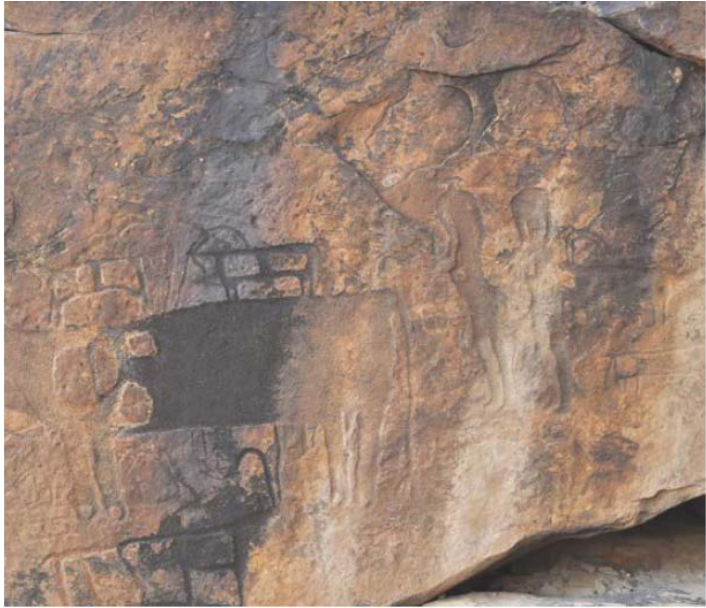
Figure 23. Standing in front of this rock art panel near Jubbah, Northern Arabia, one gets the impression as if they are Adam and Eve (author’s personal impression). The petroglyphs are probably from the